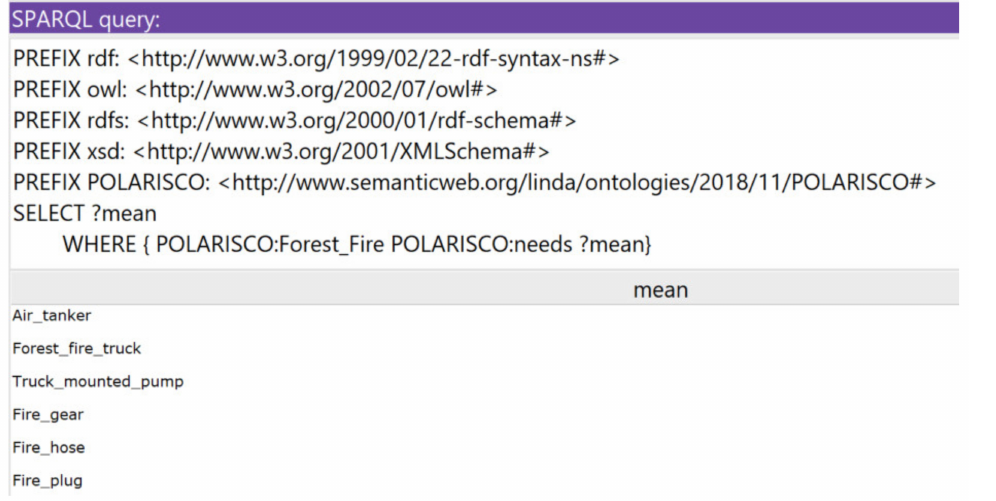
Figure 16. SPARQL query and result of the CQ1.